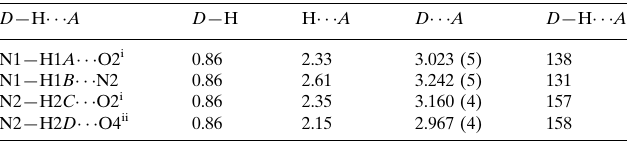
Hydrogen-bond geometry (A˚ , (cid:2)